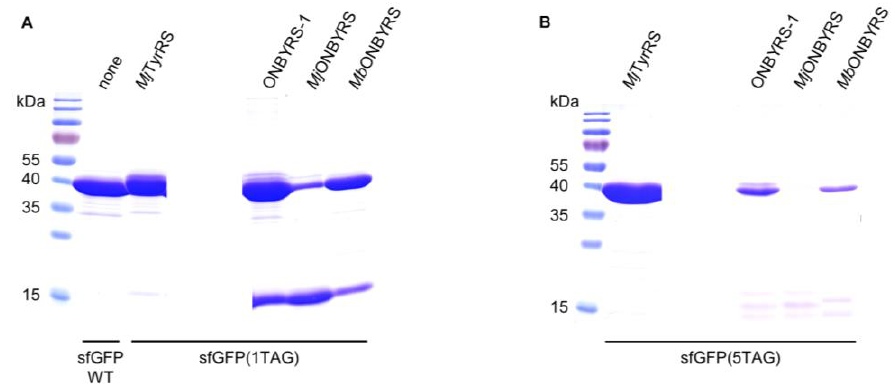
Figure 3. Coomassie-stained 15% SDS-PAGE of sfGFP(1TAG) and sfGFP(5TAG) constructs purified via Ni-NTA chromatography. ( A ) sfGFP WT and sfGFP(1TAG) constructs expressed in E. coli BL21(DE3) with different o-pairs (indicated above). ( B ) sfGFP(5TAG) constructs expressed in E. coli C321.ΔA.exp(DE3) cells with different o-pairs (indicated above). Equal volumes of pooled Ni-NTA